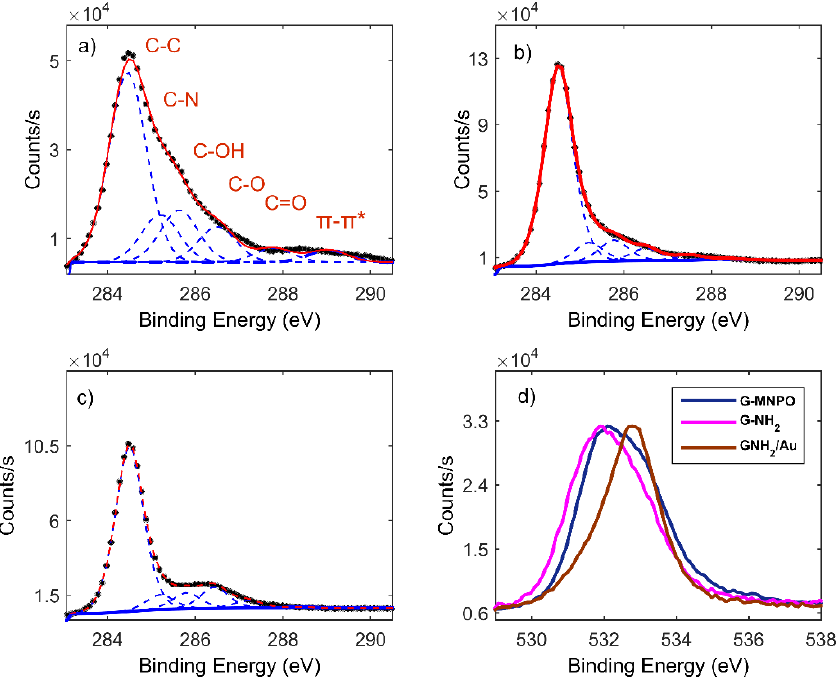
Figure 5. C 1s photoelectron deconvoluted line shapes: ( a ) G-MNPO, ( b ) G-NH 2 , ( c ) G-NH 2 / Au. ( d ) O 1s photoelectron deconvoluted line shapes of G-MNPO (blue), G-NH 2 (violet), G-NH 2 / Au (brown).